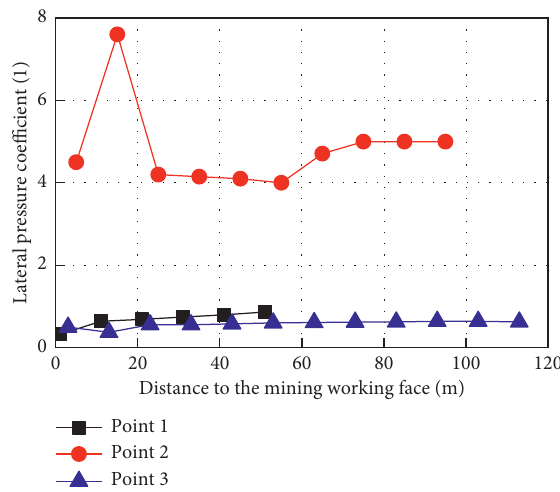
Figure 7: Lateral pressure coefficient of abnormal stress in front of the mining working face.